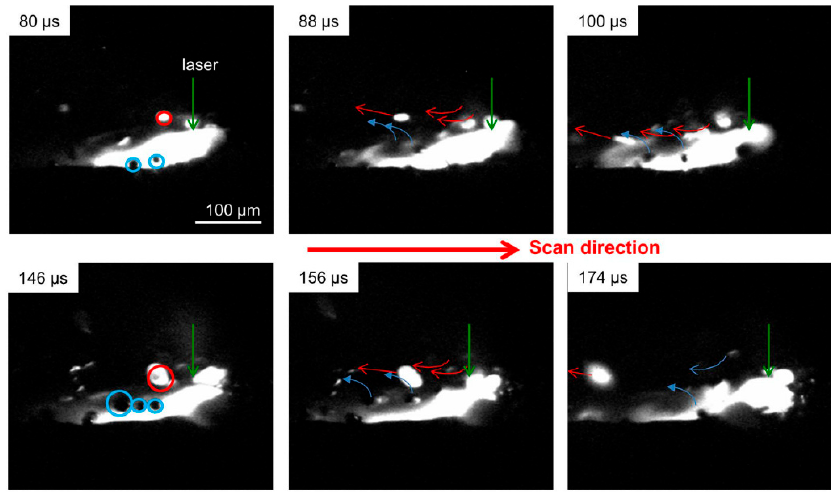
Figure 4. High-resolution images of the melt-pool formation (300 W, 1.5 m/s). Adapted from Reference [35] with permission from Springer Nature.